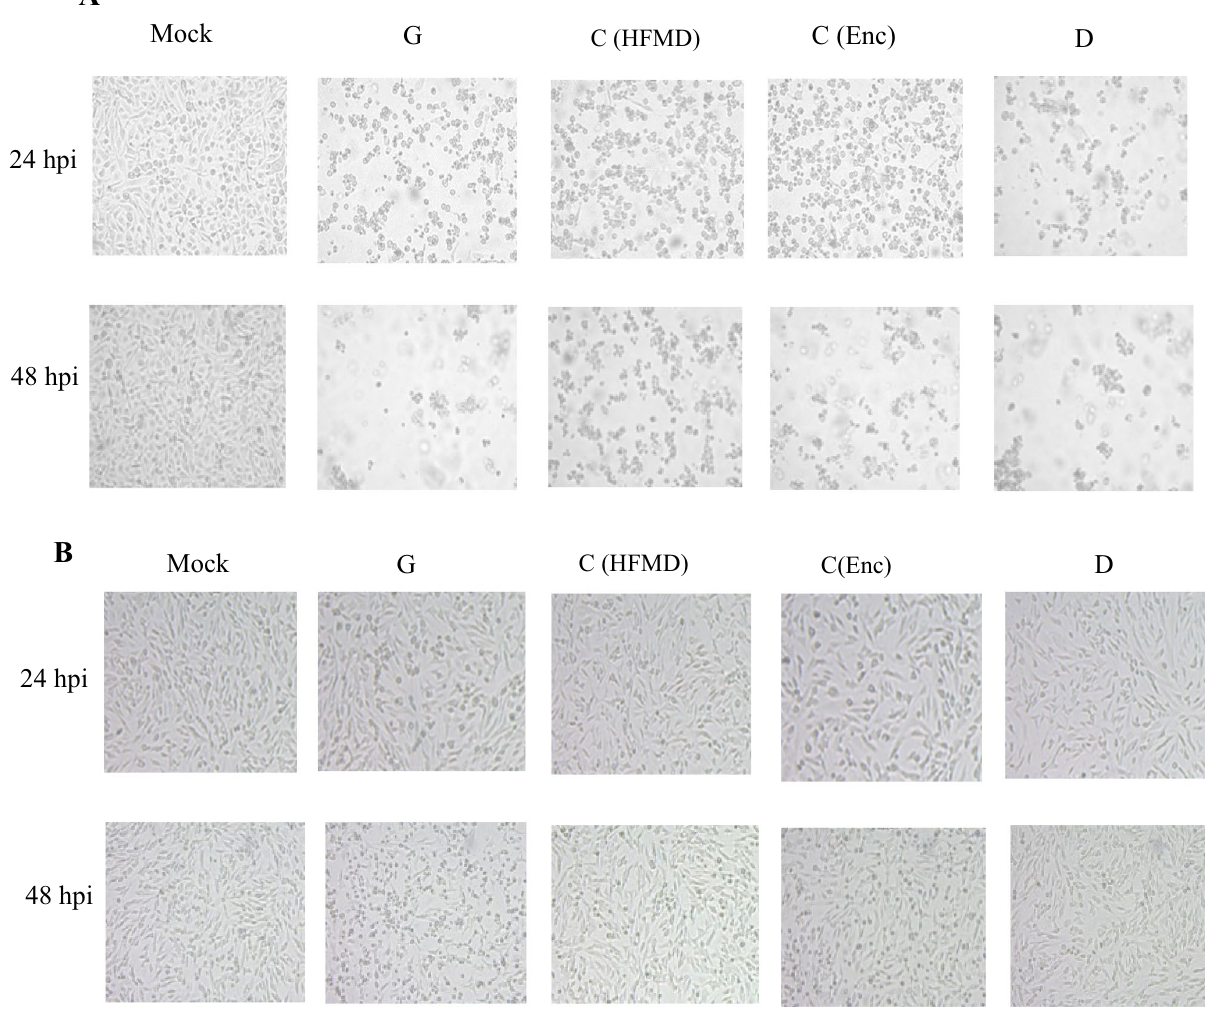
Figure 1. Cytopathic effect in human cells infected with the four clinically different EV-A71 isolates comprising of EV-A71 genotype G, EV-A71 genotype C(HFMD), EV-A71 genotype C (Enc) and EV-A71 genotype D ( A ) Cytopathic effect in human muscle cells (RD-A) at 24 h and 48 h post infection. ( B ) Cytopathic effect in human neuronal cells (SK-N-SH) at 24 h and 48 h post infection. Three independent experiments were performed, representative image of one experiment